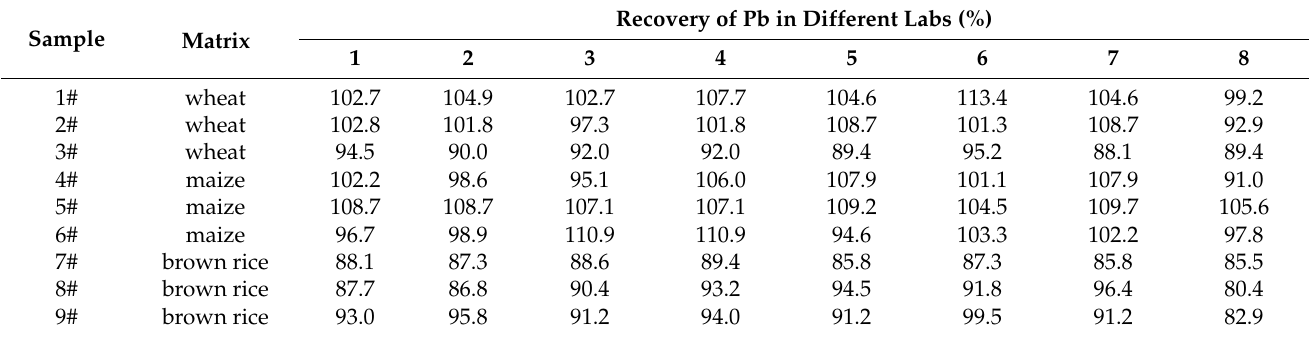
Table 7. Results of Pb by GFAAS with LCC-HCL in real samples (n = 3).